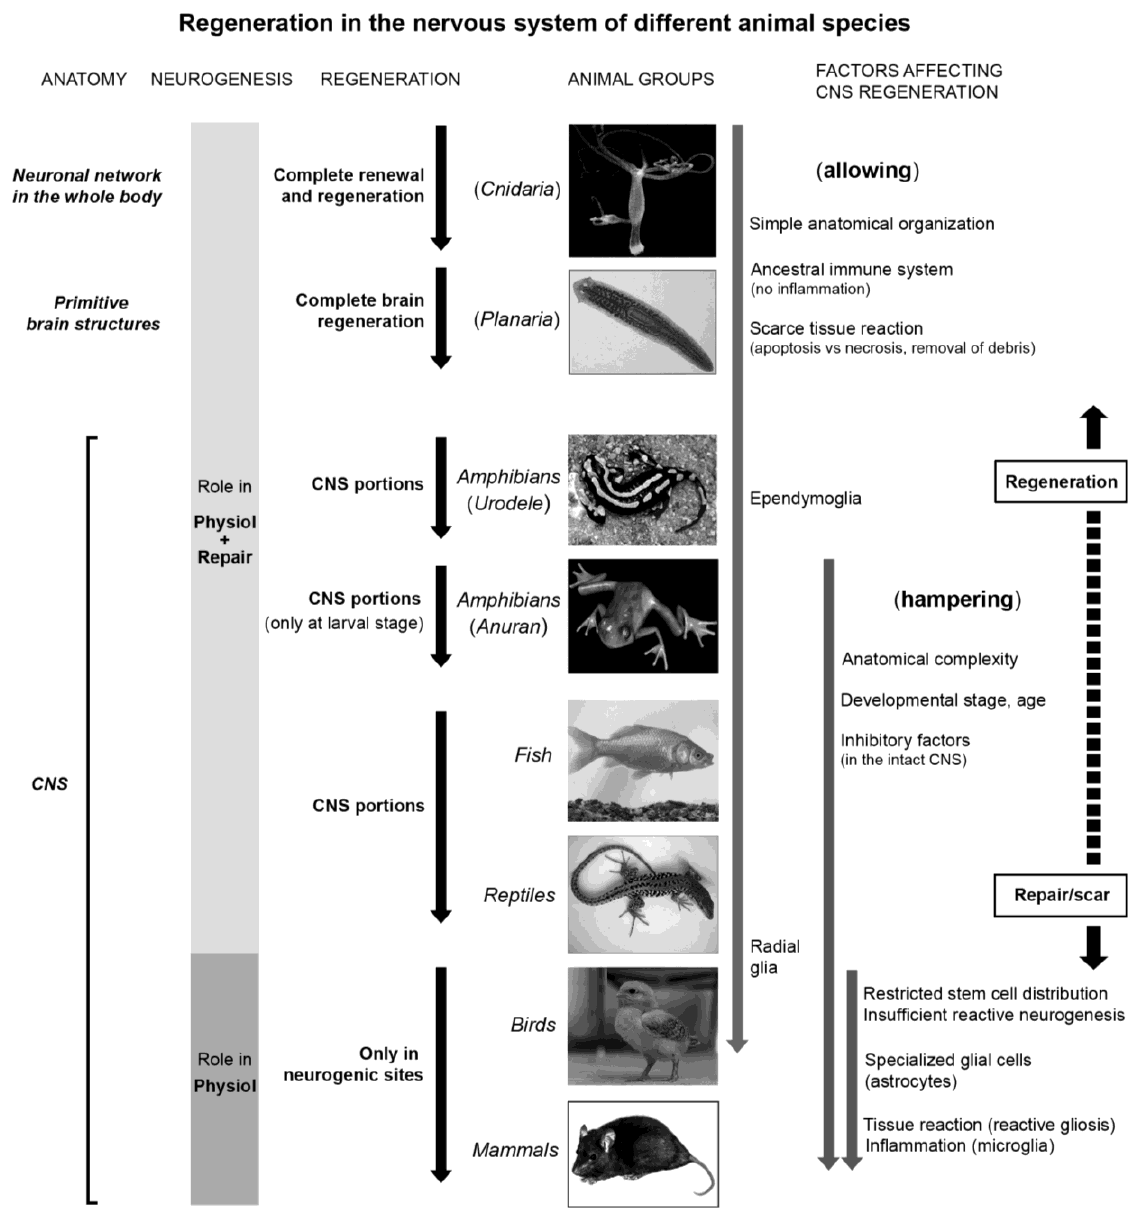
FIGURE 3. Schematic representation of the progressive restriction of regenerative capacity in the nervous system of different animal species, put in relation with several